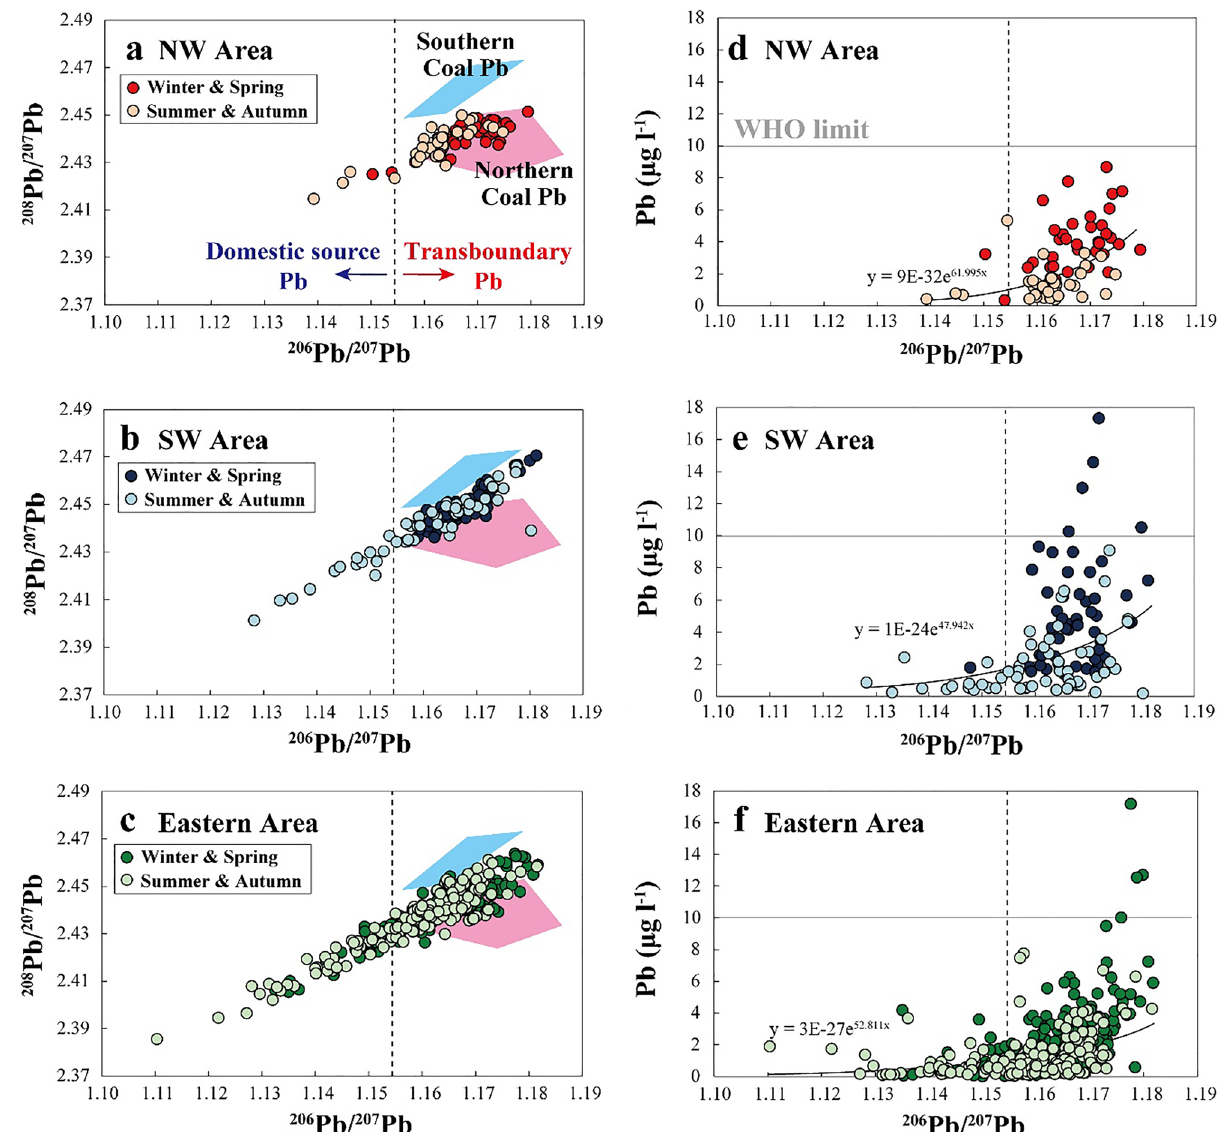
Figure 3. Provenance of Pb pollution. ( a–c ) 206 Pb/ 207 Pb versus 208 Pb/ 207 Pb diagrams showing relative source dominance of Pb in precipitation samples collected over Japanese archipelago between different regions and seasons. ( d–f ) 206 Pb/ 207 Pb versus Pb concentration diagrams showing more elevated concentrations associated with more contribution from transboundary Pb rather than domestic-source